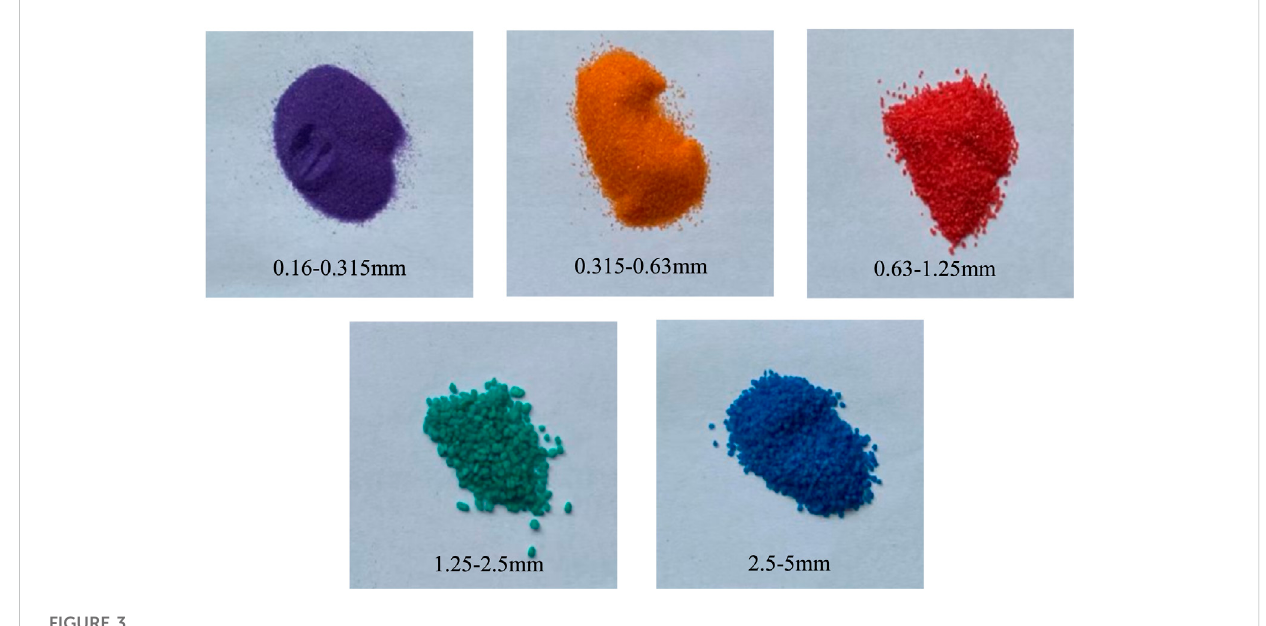
FIGURE 3 Colored sand with different particle sizes.